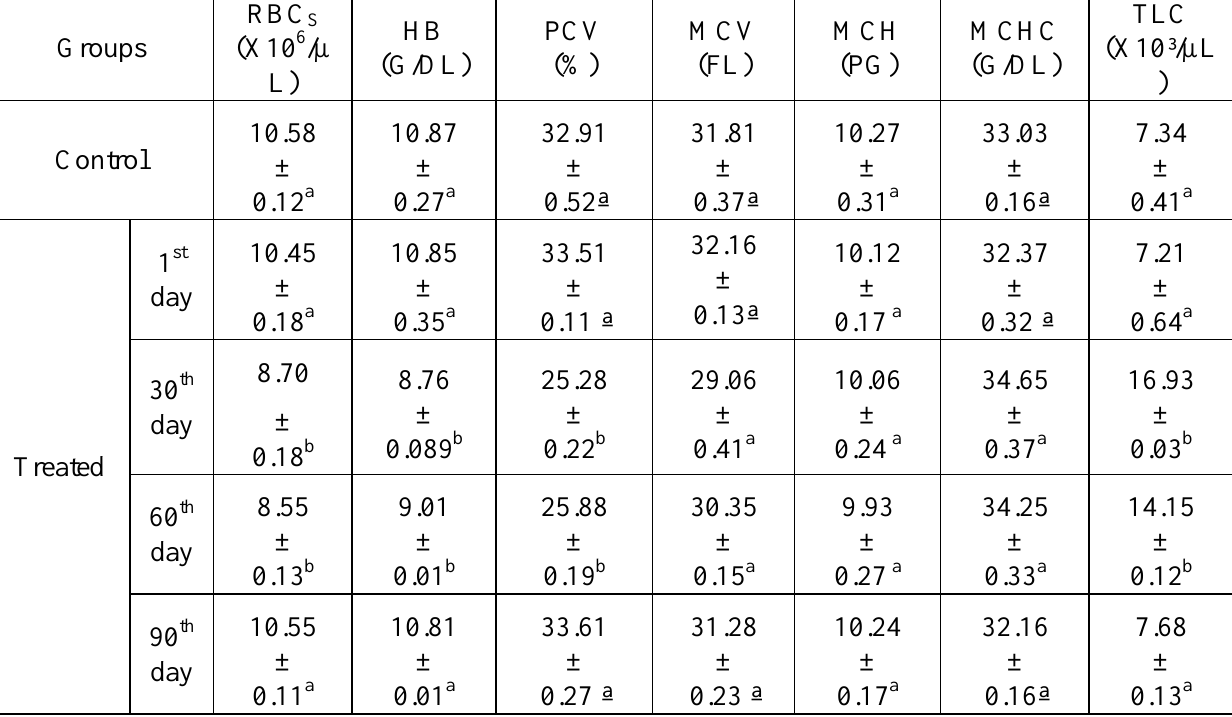
Table 1: IVM's effects on hematological parameters in ewes